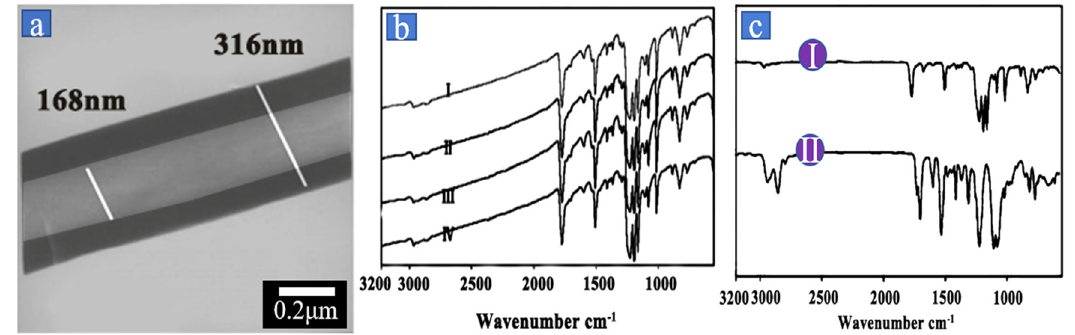
Figure 12: ( a ) TEM image of transmission electron microscopy of the PU ( core ) /PC ( shell ) fi ber; ( b ) FT - IR spectra of various fi ber samples of PU ( core ) /PC ( shell ) : 20 wt%/4 wt%; 20 wt%/6 wt%; 20 wt%/8 wt%; and 20 wt%/10 wt%; ( c ) FT - IR spectra of various fi ber samples ( I: PC, II: PU ) . ( a – c ) Adapted with permission ( 132 ) Copyright 2008, Society of Plastics